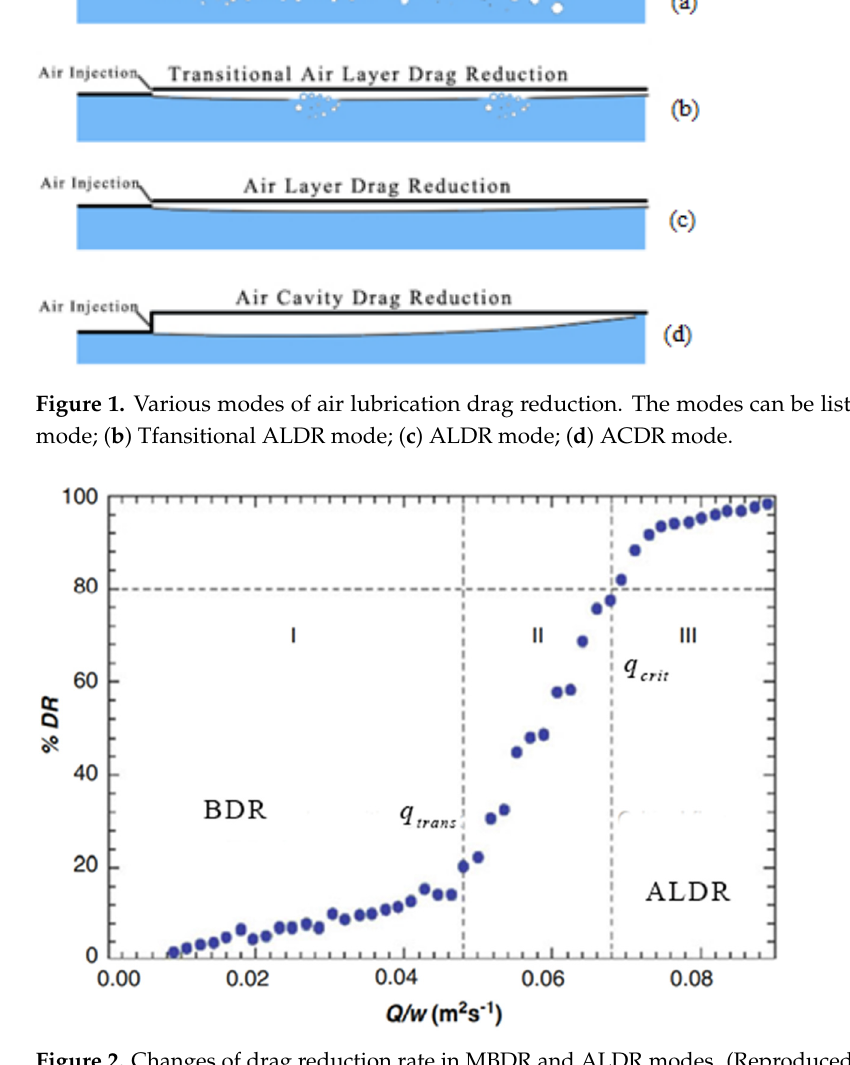
Figure 2. Changes of drag reduction rate in MBDR and ALDR modes. (Reproduced with permis- sion from Elbing, B.R, The Journal of Fluid Mechanics ; published by Cambridge University Press, 2008.)